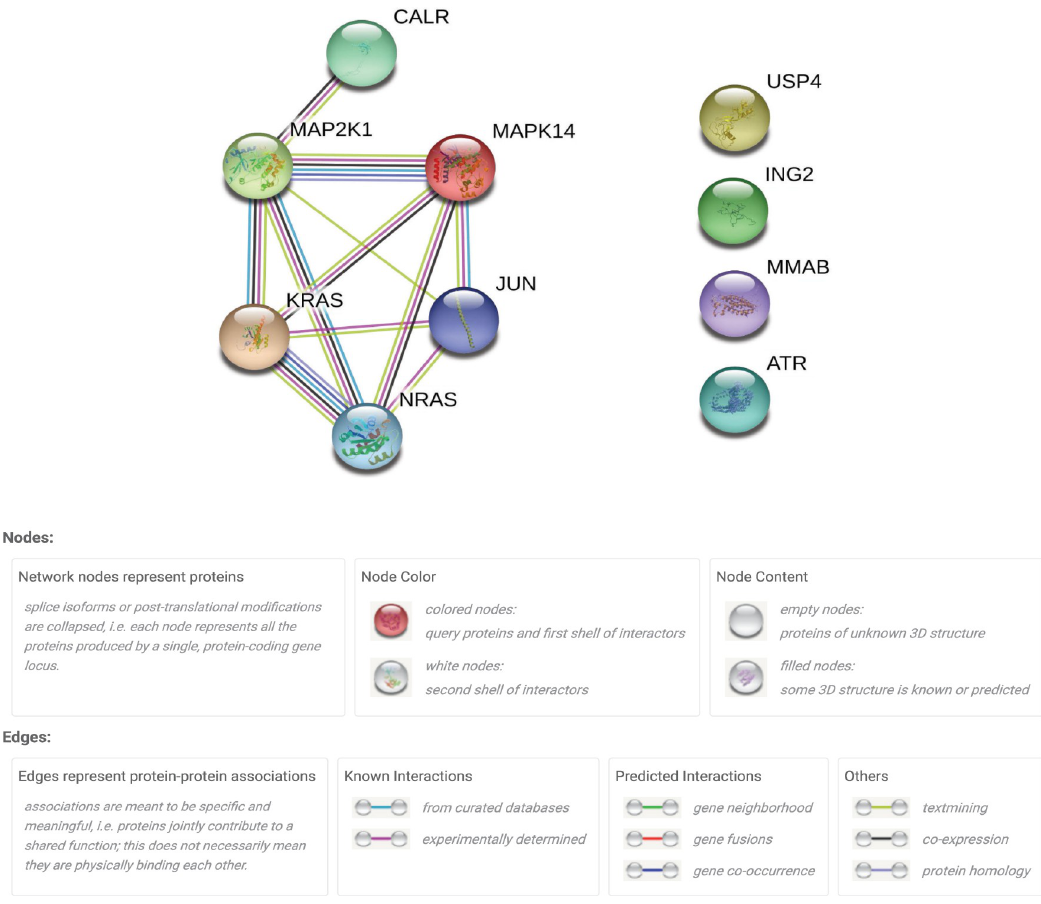
Fig 1. Conserved pathways between process of cellular senescence and functional decline. A group of 10 genes was identified as common to functional decline and senescence. Many of these genes interact in the MAP kinase pathway, as shown by this protein- protein interaction plot from